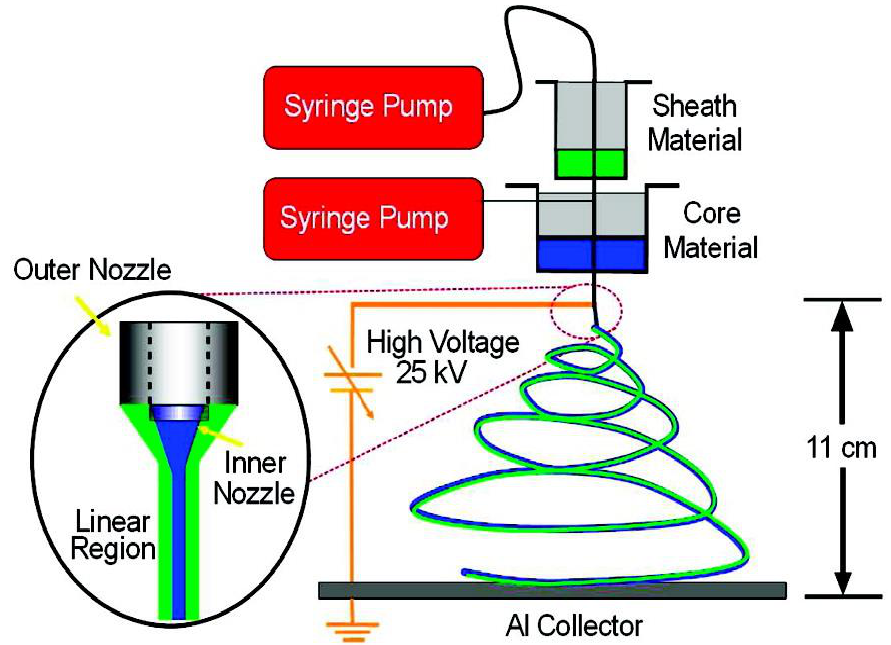
Figure 2. Schematic of coaxial electrospinning setup. The inset shows an illustration of a coaxial jet under applied voltage [39]. Reprinted with permission from Ref. [39]. Copyright American Chemical Society, 2010.